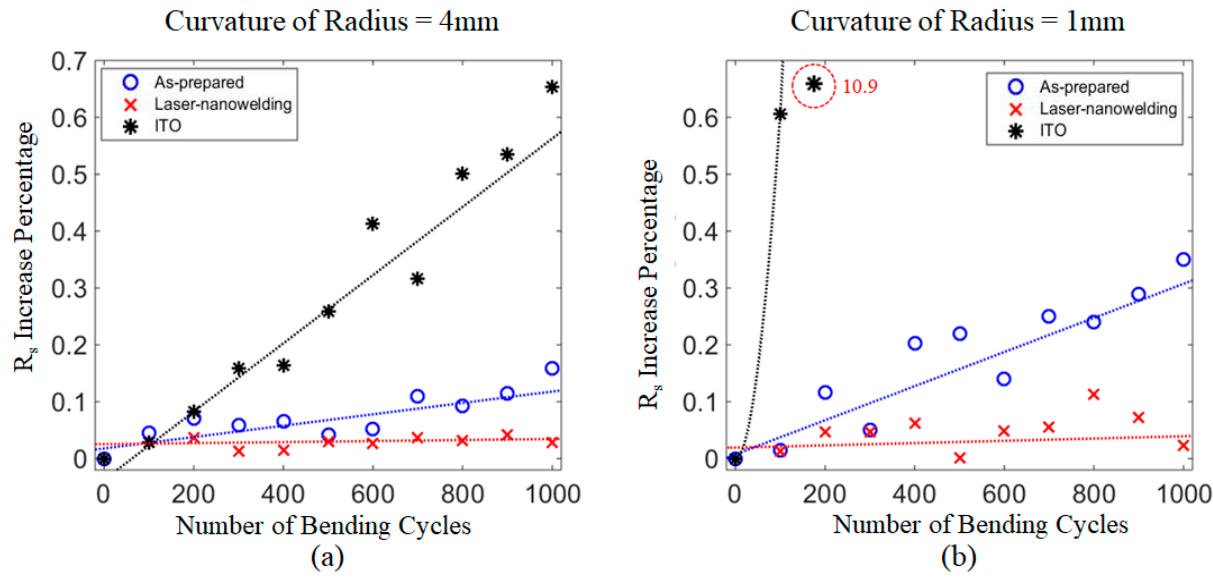
Figure 8. Sheet resistance (Rs) increase percentage of bending tests at the radius of curvature of ( a ) 4 mm and ( b ) 1 mm. adjust the distance between the clamps. Samples were stretched to a certain strain